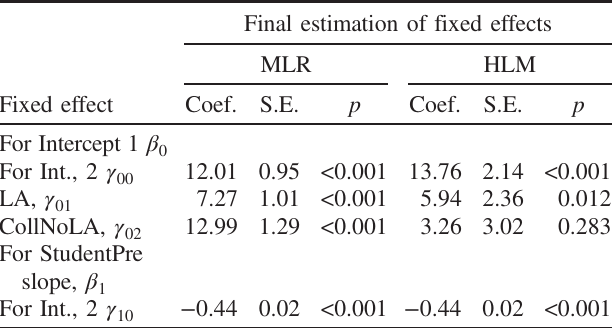
TABLE VI. MLR and HLM coefficients for model 3. Variable labeling is consistent with the HLM model.